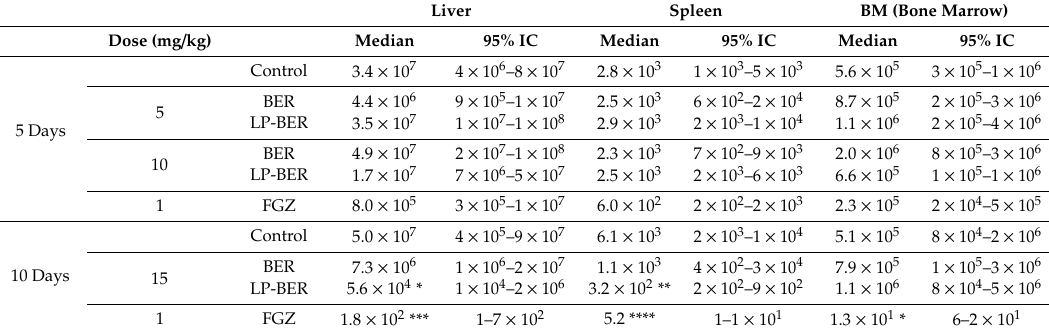
Table 6. In vivo e ffi cacy studies in a Leishmania infantum visceral murine model. Parasite burden in liver, spleen and BM was measured by qRT-PCR after 5 or 10 consecutive days of i.p. treatment with free BER and LP-BER at 5, 10 and 15 mg / kg. Fungizone ® (FGZ) i.v. administered at 1 mg / kg was used as positive control. Results expressed as median ± 95% IC (n = 6 per group). Data analyzed using a nonparametric Kruskal–Wallis test, followed by Dunn’s multiple comparison. * p < 0.05, ** p < 0.01, *** p < 0.001 and **** p < 0.0001.